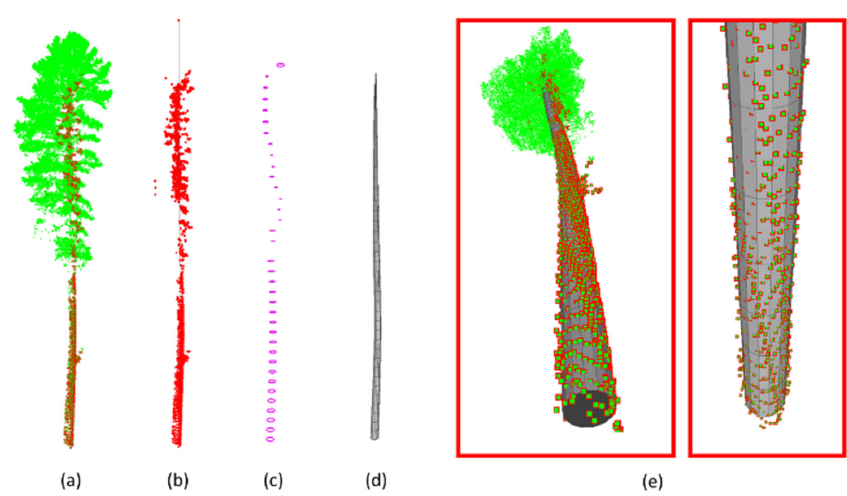
Figure 5. An example of the output of Windrim and Bryson’s [126] (Figure 8) deep learning model where ( a ) is the segmented point cloud, ( b ) isolated stem points, ( c ) RANdom SAmple Consensus (RANSAC) algorithm circles attach stem section and ( d ) refined stem sections estimate based on robust least ‐ squares fitting process. Panel ( e ) shows examples of the final fitted stem model.